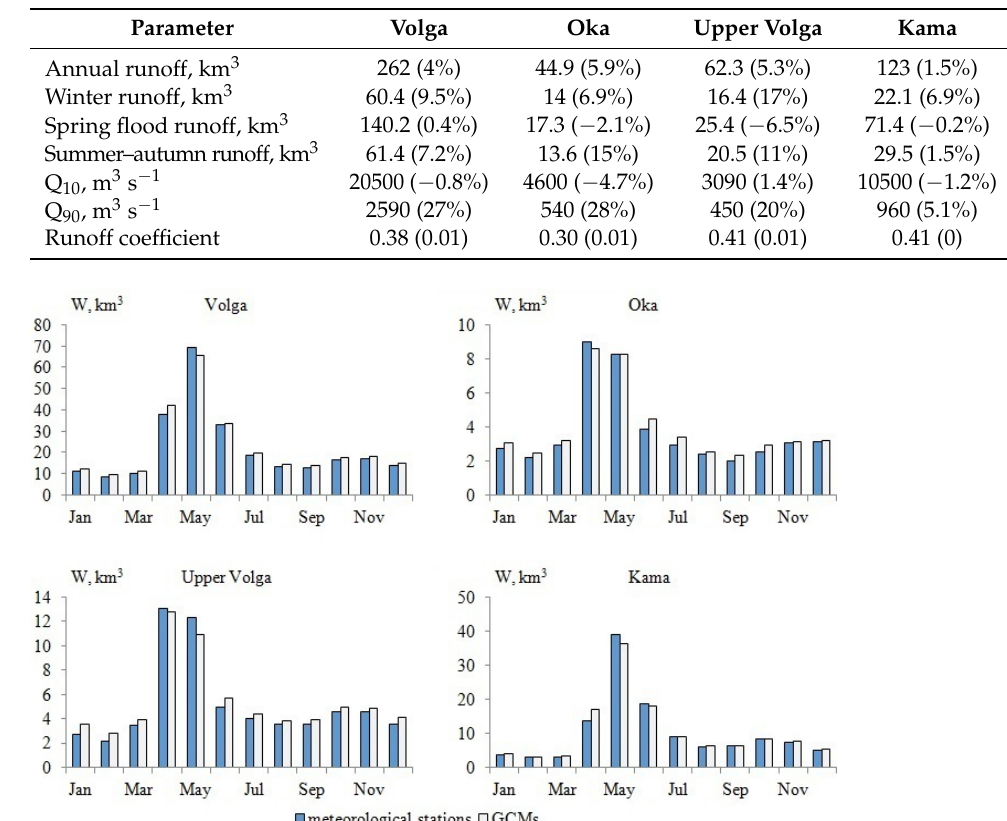
Table 5. Water regime characteristics of the Upper Volga, Oka, Kama and Volga rivers, calculated from meteorological stations data and errors according to the GCMs ensemble data (in parentheses) for the period 1970–1999.